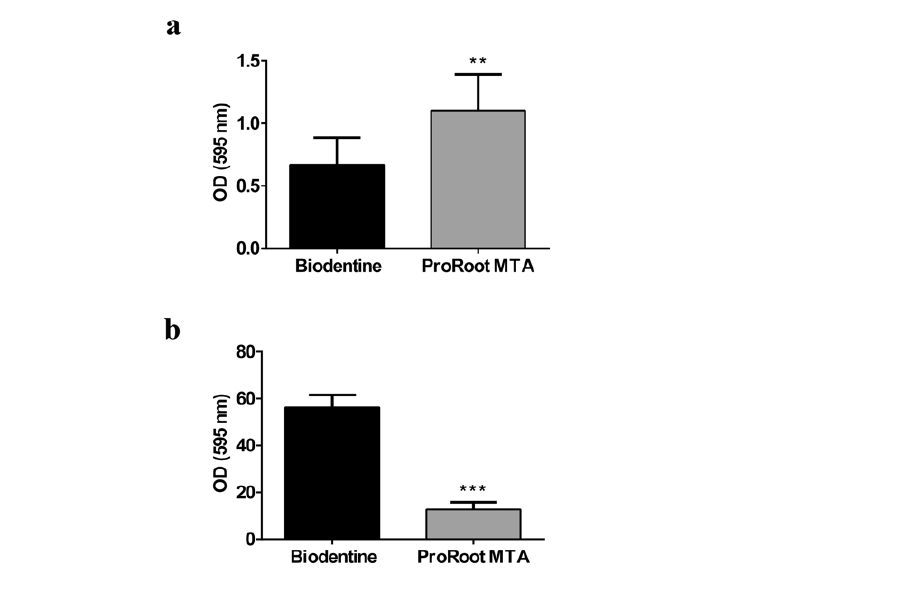
Figure 10. Periapical radiographs of the dental element (3.6) treated with Biodentine. The immature permanent tooth is shown immediately after vital pulp therapy (Baseline) ( a ) and after 1 month ( b ), 3 months ( c ), and 1 year of follow-up ( d ). Progressive formation of the dental roots could be ob- served over time with an absence of periapical reaction.